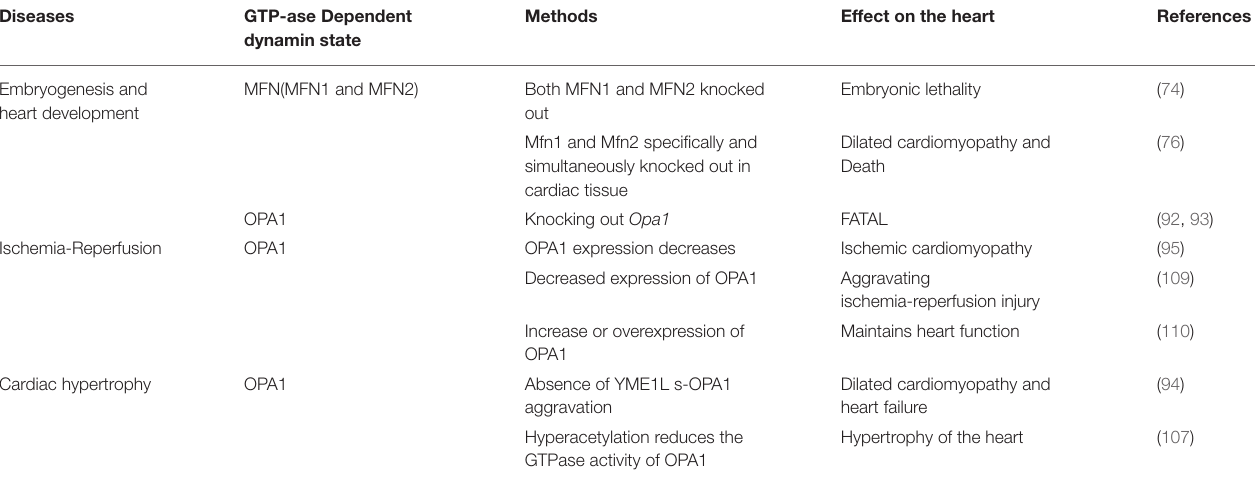
TABLE 2 | The role of GTPase-dependent fusion proteins in heart development and heart